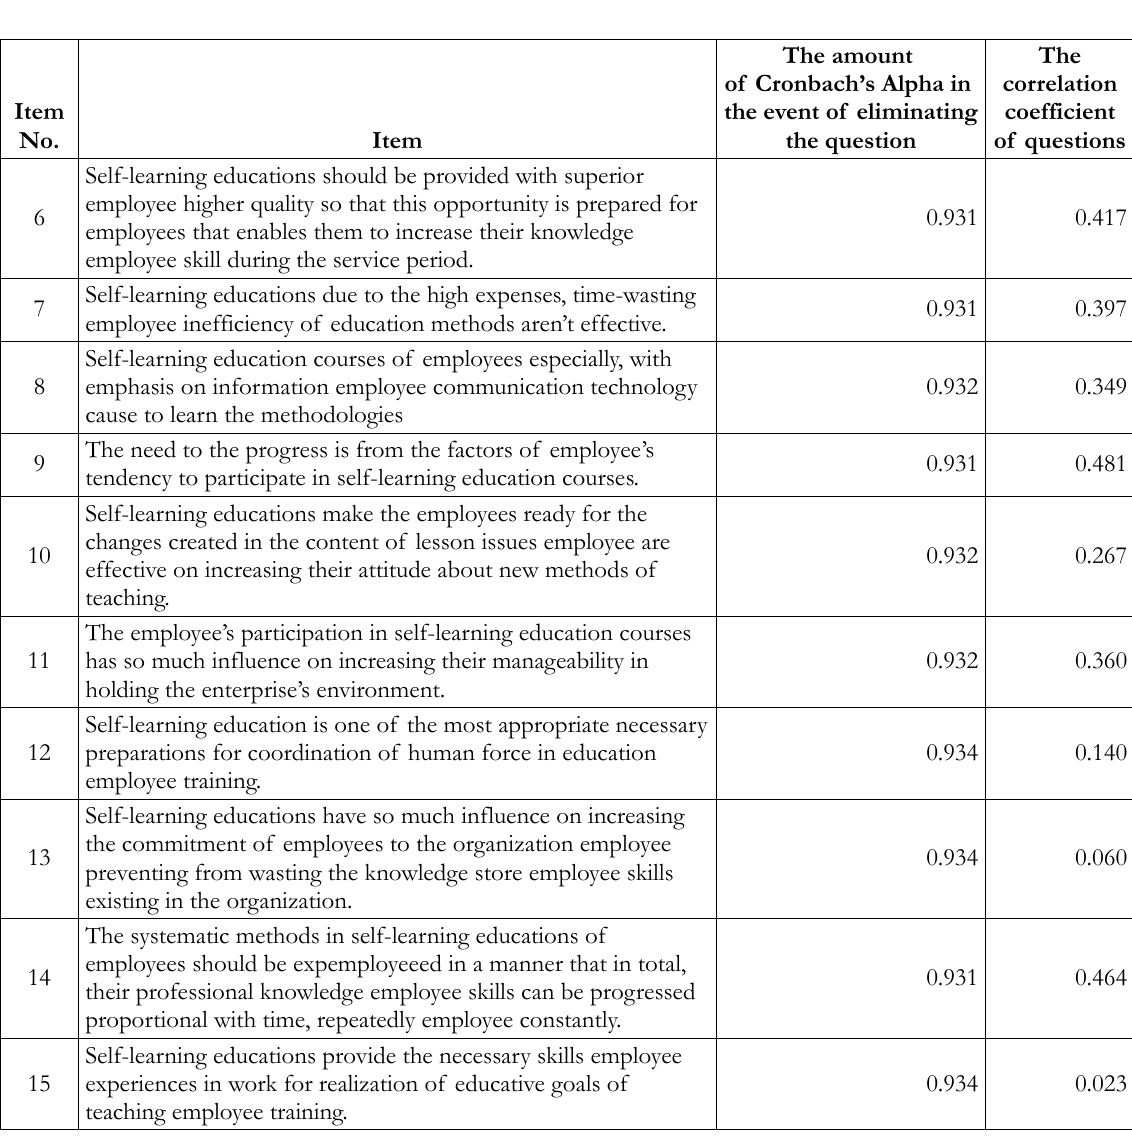
Table 2. The correlation rate of each question with total questions of self-learning education